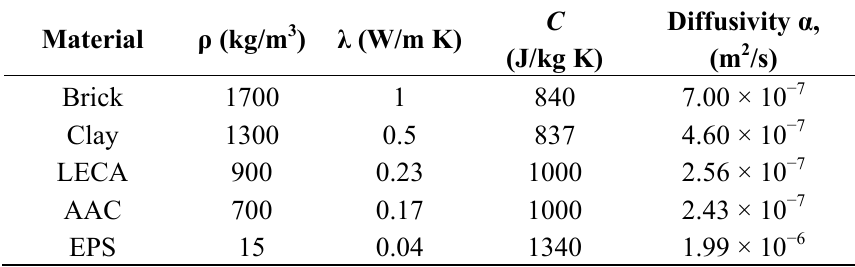
Table 3. Material thermo-physical properties.